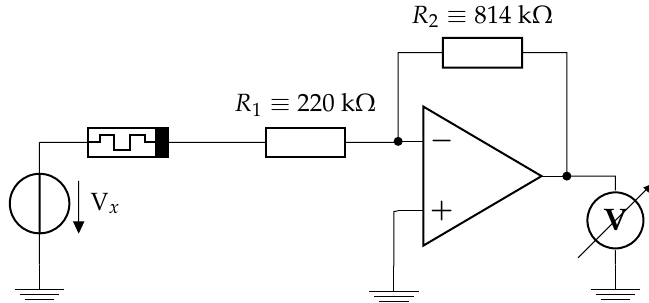
Figure 1. Measurement environment circuit. The measurement setup consists an amplifier circuit as a current controlled voltage source and a current regulator resistor. The used amplifier is a “TL082”. The applied voltage V x was strictly between − 2.5 V and 2.5 V. The memristor symbol represents either a single memristor or a network of memristors depending on the